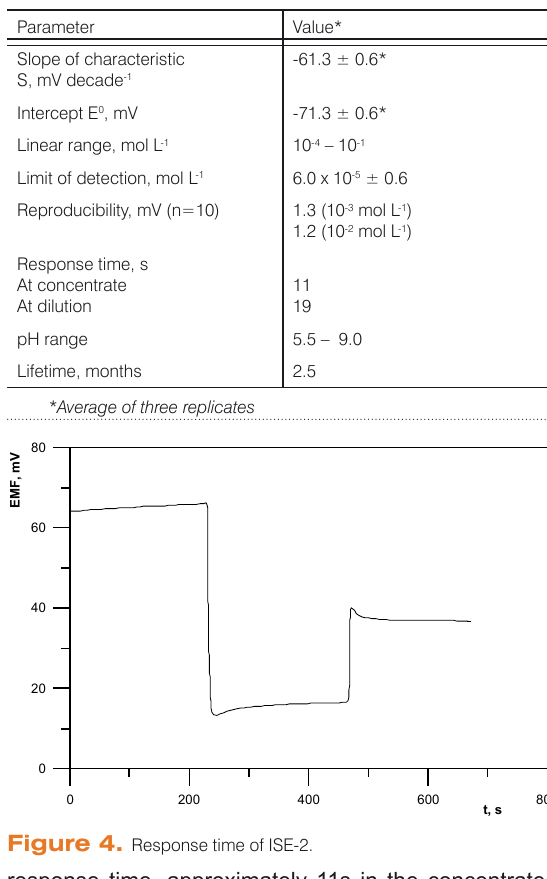
Table 4. Analytical parameters of naproxen electrode ISE-2.